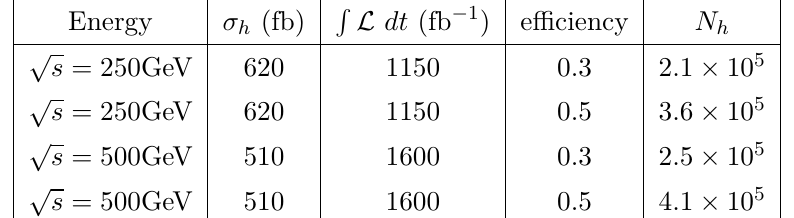
Figure 5 . The γ h β h distributions for the produced Higgs bosons. Left panel: √ panel: s = 500 GeV.